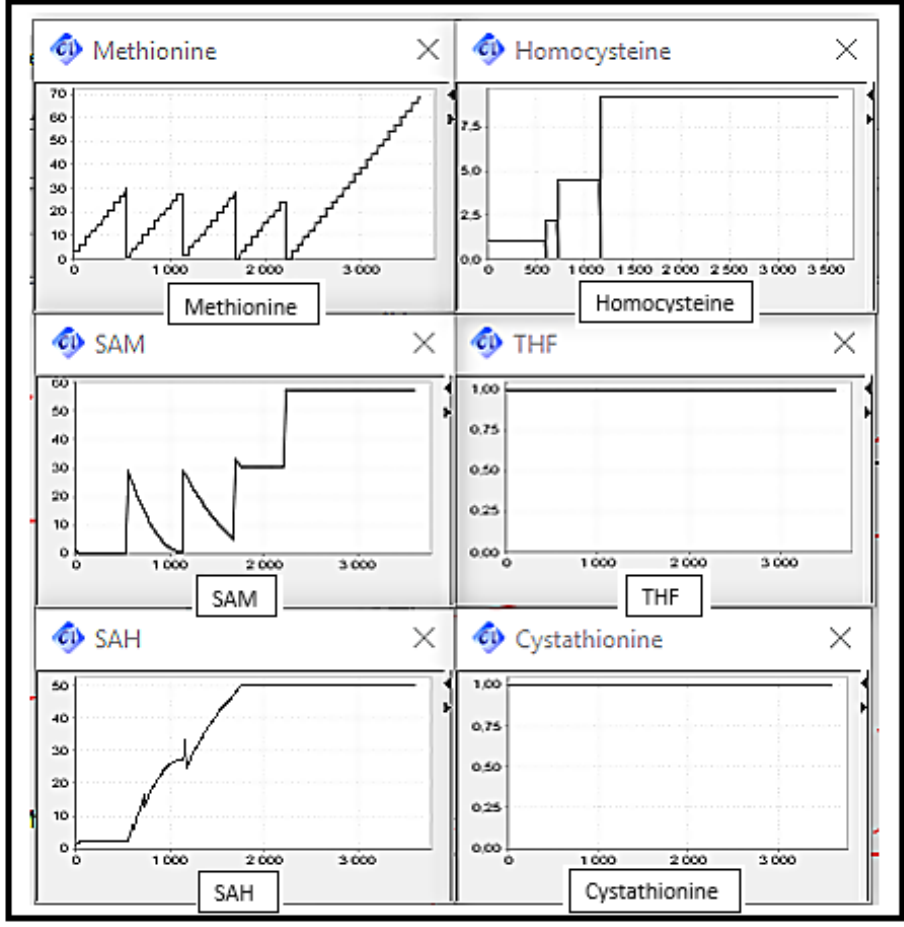
Figure 12. Simulation of the HFPN model representing the studied metabolic pathway in case of MS and CBS Deficiencies (Scenario